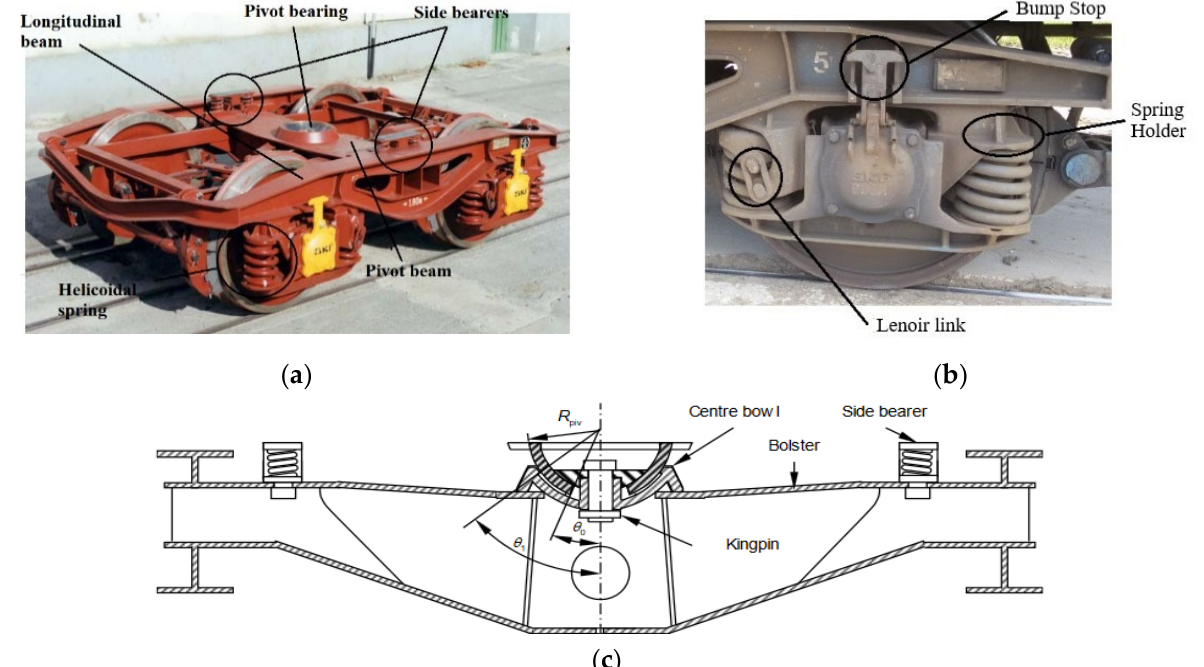
Figure 4. Y21 bogie: ( a ) overview and main elements, ( b ) primary suspension detail, ( c ) cross ‐ section in the transverse direction (adapted from [22]).